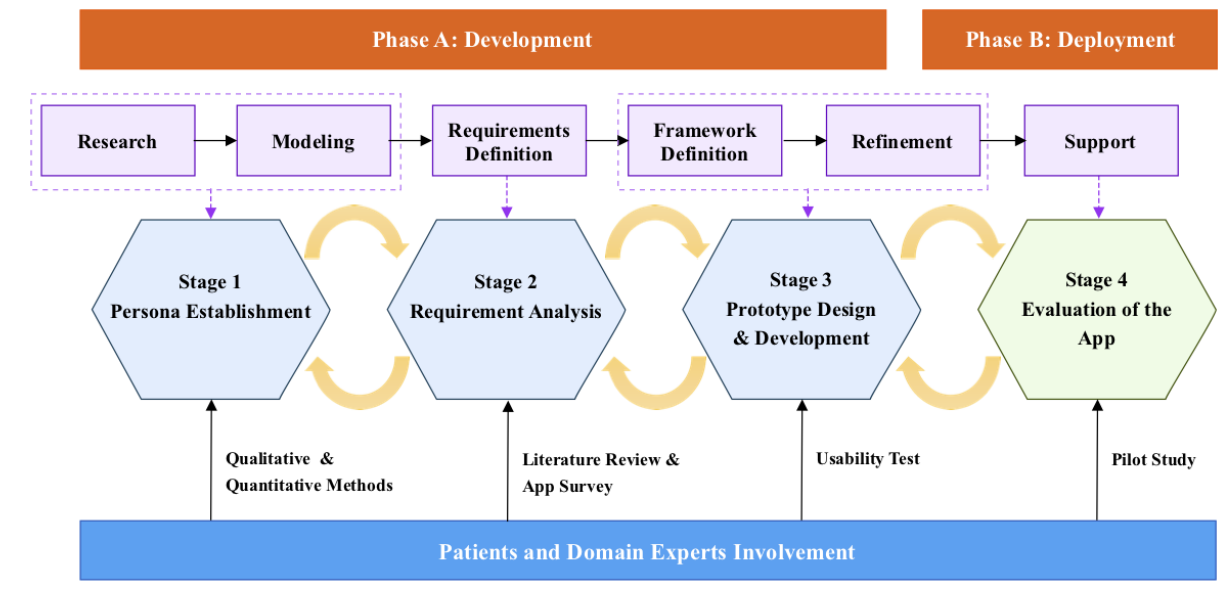
Figure 2. Complete study